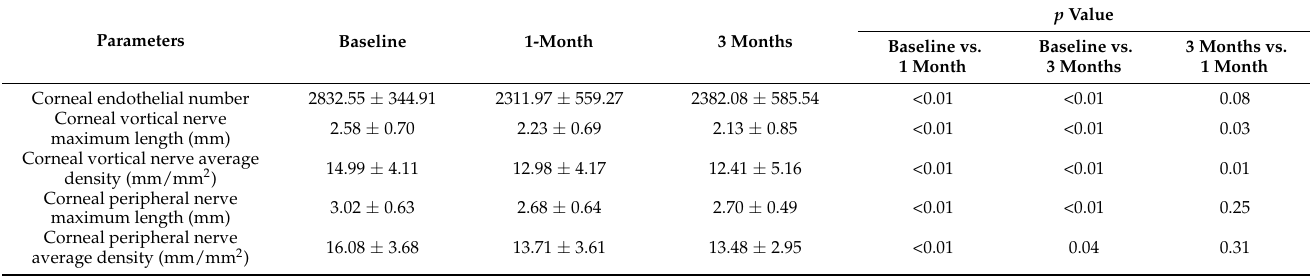
Table 2. Comparison of the ICVM parameters before and after cataract